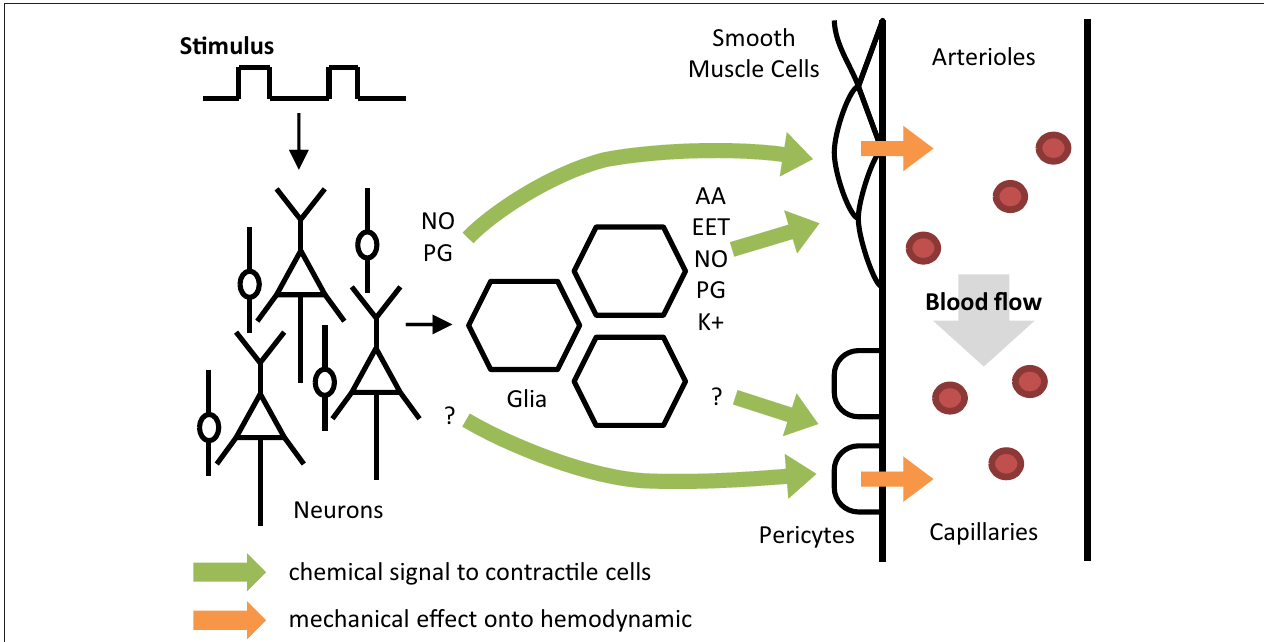
FIGURE 2 | A conceptual one direction model of neurovascular coupling. Colored arrows represent the relationship between different activities: neurons, glia, smooth muscle cells, pericytes, and blood flow. NO, nitric oxide; PG, prostaglandin; AA, arachidonic acid; EET, epoxyeicosatrienoic acids; K, potassium.